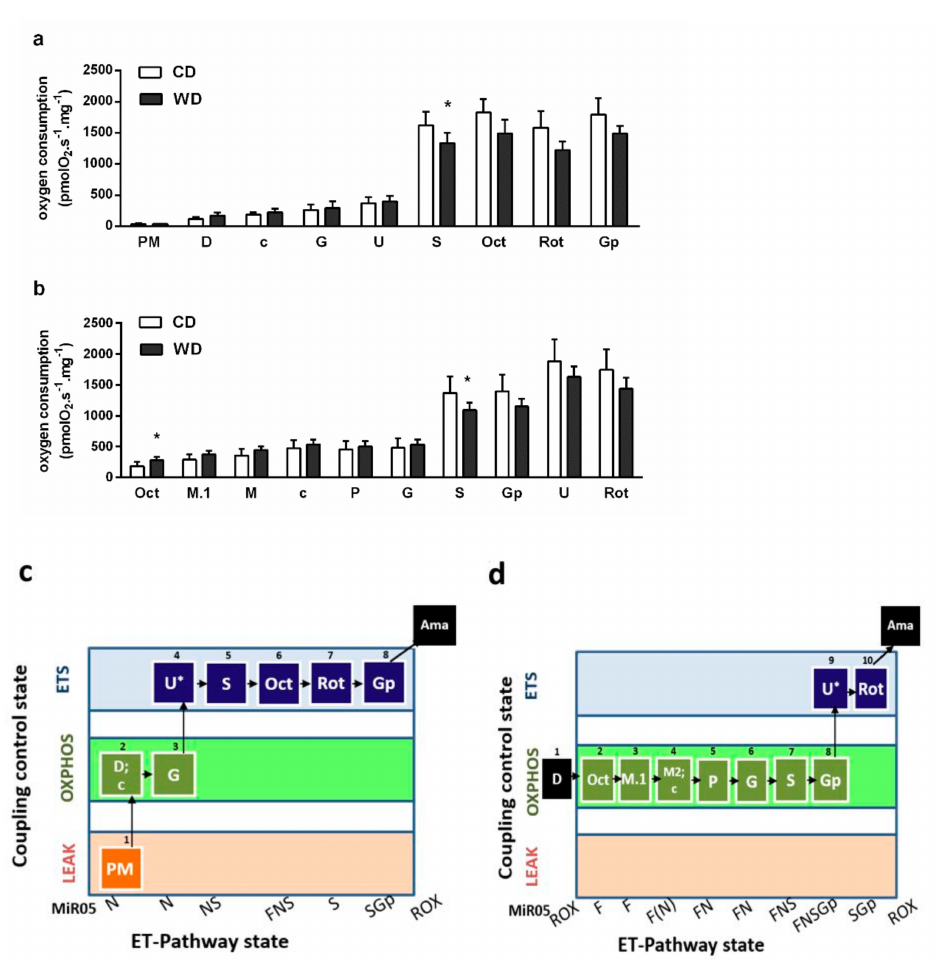
Figure 9. Mitochondrial respiration in mice fed a control diet (CD) and a Western-style diet